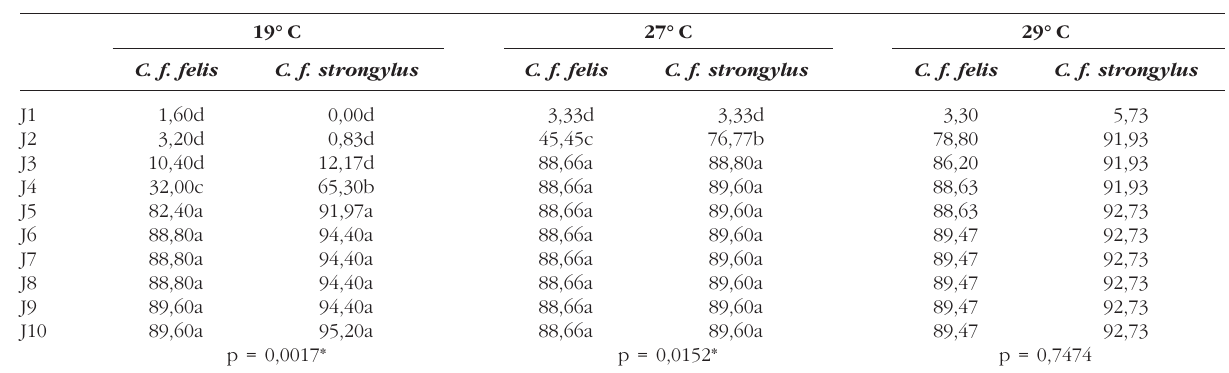
Fig. 2. – Taux moyens d’éclosion des œufs en fonction de la tempéra- ture chez C. f. felis.